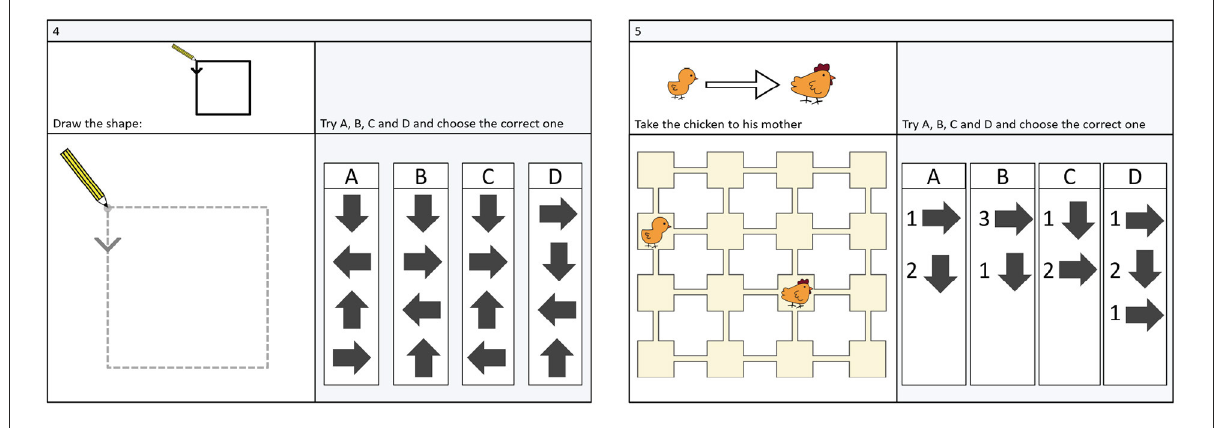
FIGURE1 The two main question formats of the BCTt and cCTt: grid (Left) and canvas (Right) (Figure taken from El-Hamamsy et al., 2022a).